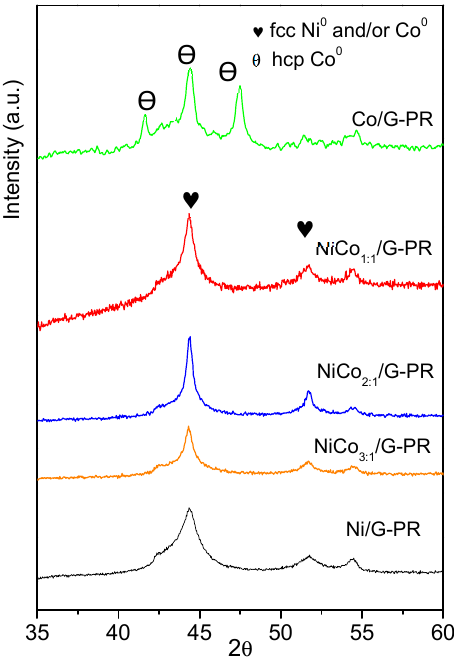
Figure 10. XRD pattern obtained for the spent catalysts.